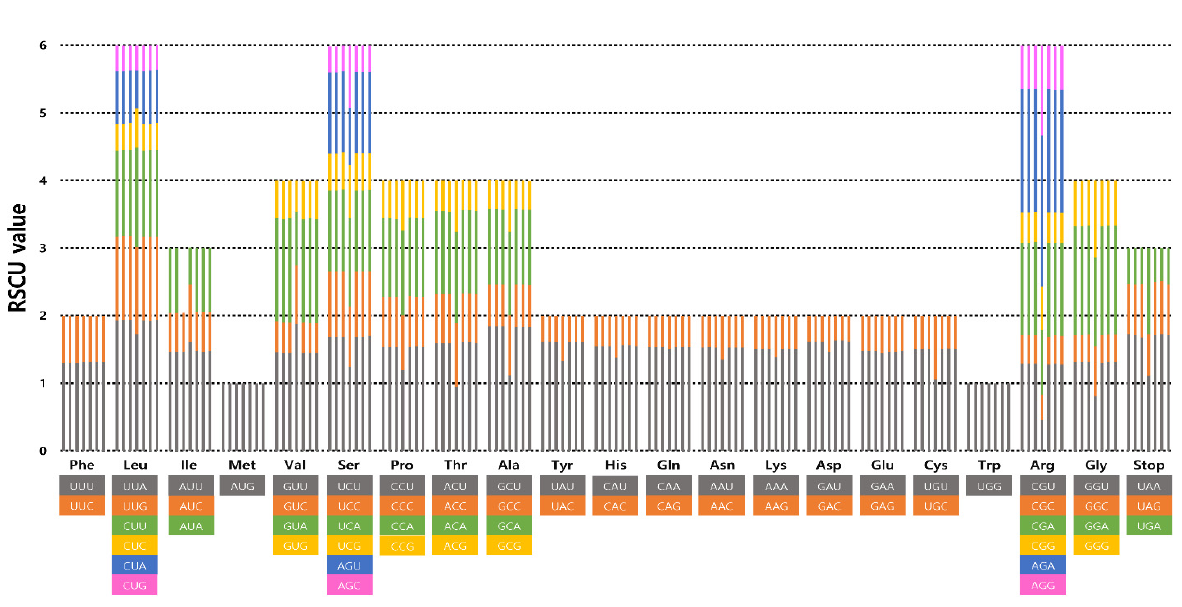
Figure 2. Codon distribution and relative synonymous codon usage in the plastomes of seven newly sequenced Cotoneaster species, Ulleung Island endemic C. wilsonii , and seven representative lineages within the genus. The list of species from left to right columns represent C. dielsianus , C. hebephyllus ,